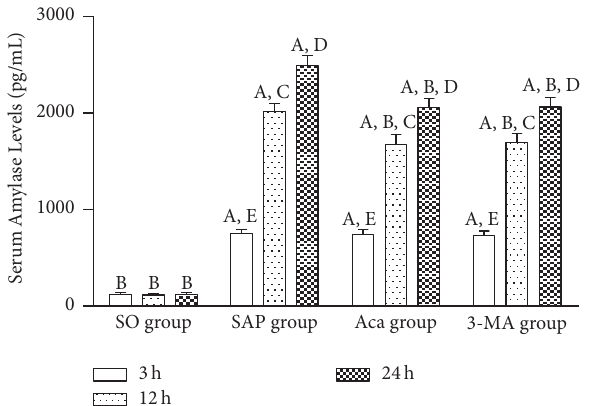
Figure 2: Comparison of serum amylase levels at 3, 12, and 24 h in four groups. A 𝑃 < 0.01 versus SO group at the same time point; B 𝑃 < 0.01 versus SAP group at the same time point; 12h versus 3 h in the same group, C 𝑃 < 0.01 ; 24 h versus 12 h in the same group, D 𝑃 < 0.01 ; 24h versus 3h in the same group, E 𝑃 < 0.01